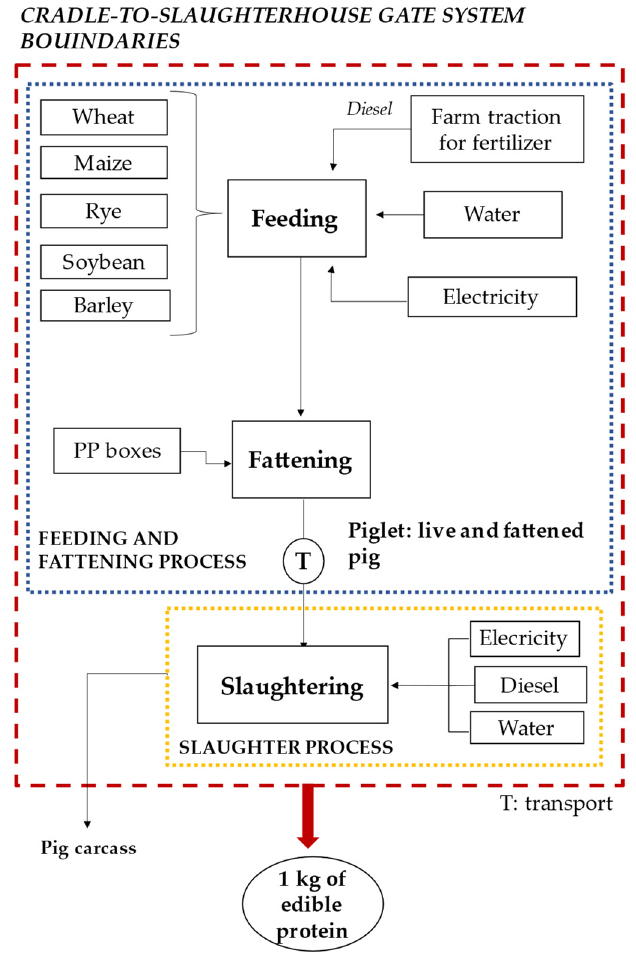
Figure 2. The system boundaries for pork meat production.